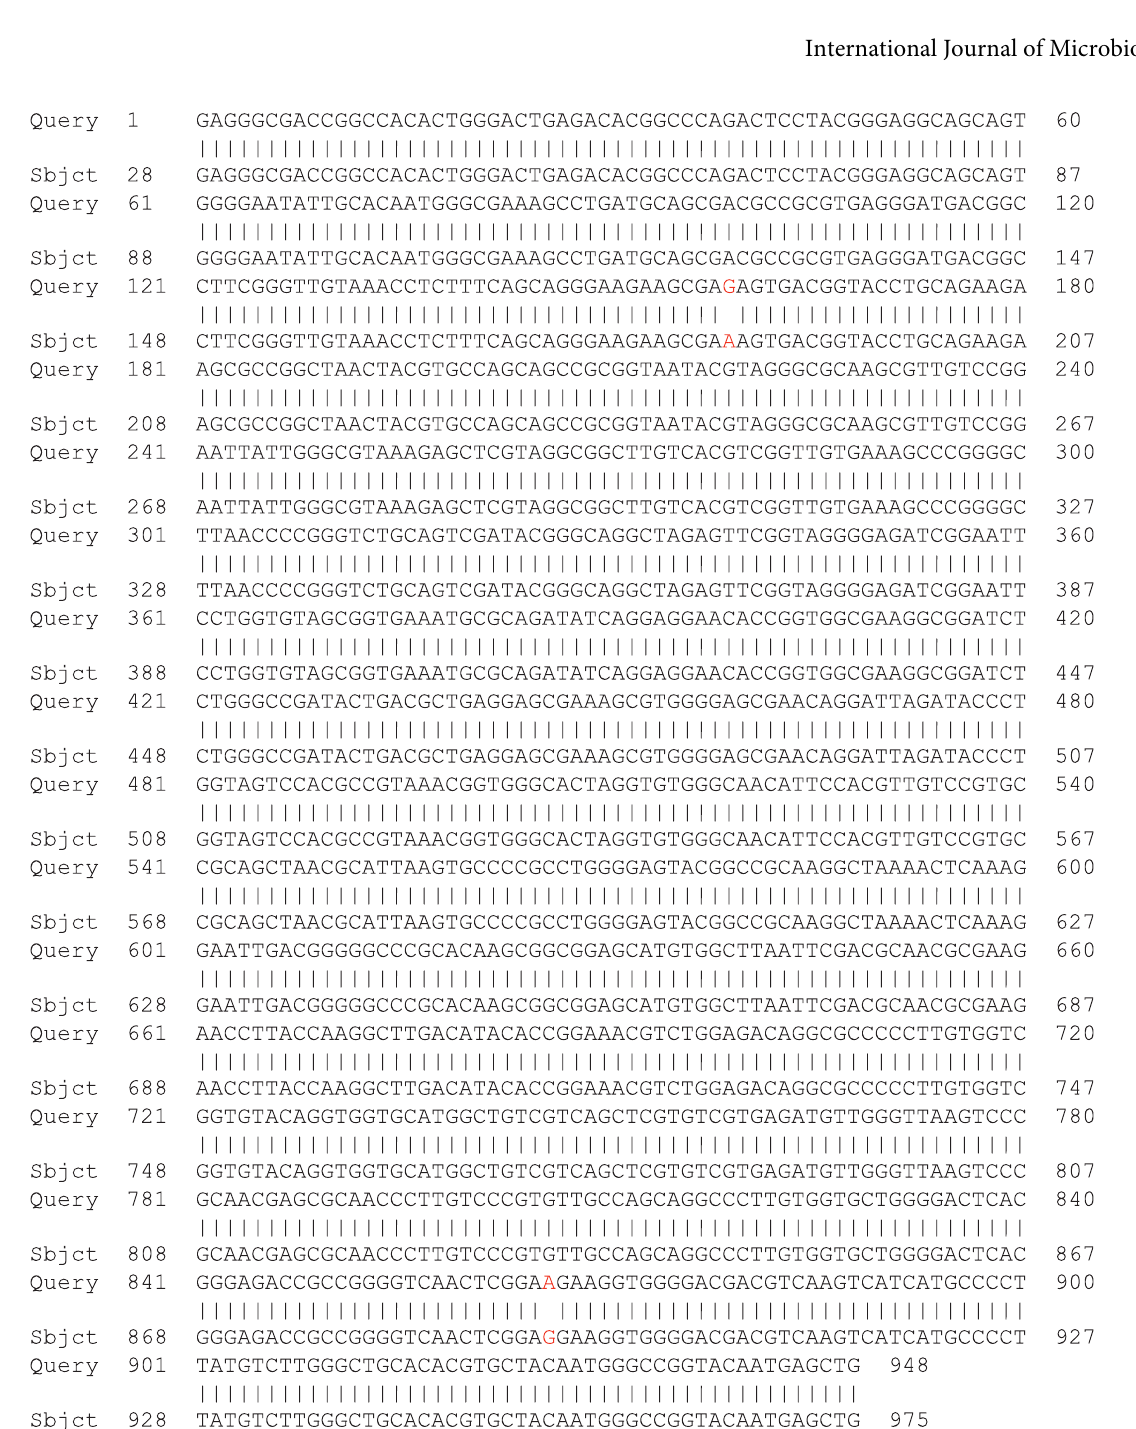
Figure 12: The BLASTanalysis between the KGT32 (query) sequence and Streptomyces sp. strain SP4-AB2 (sbjct � subject) sequence from the NCBI database. The nucleotide with red color indicates the difference between the query (KGT32) and the subject ( Streptomyces sp. strain SP4-AB2)